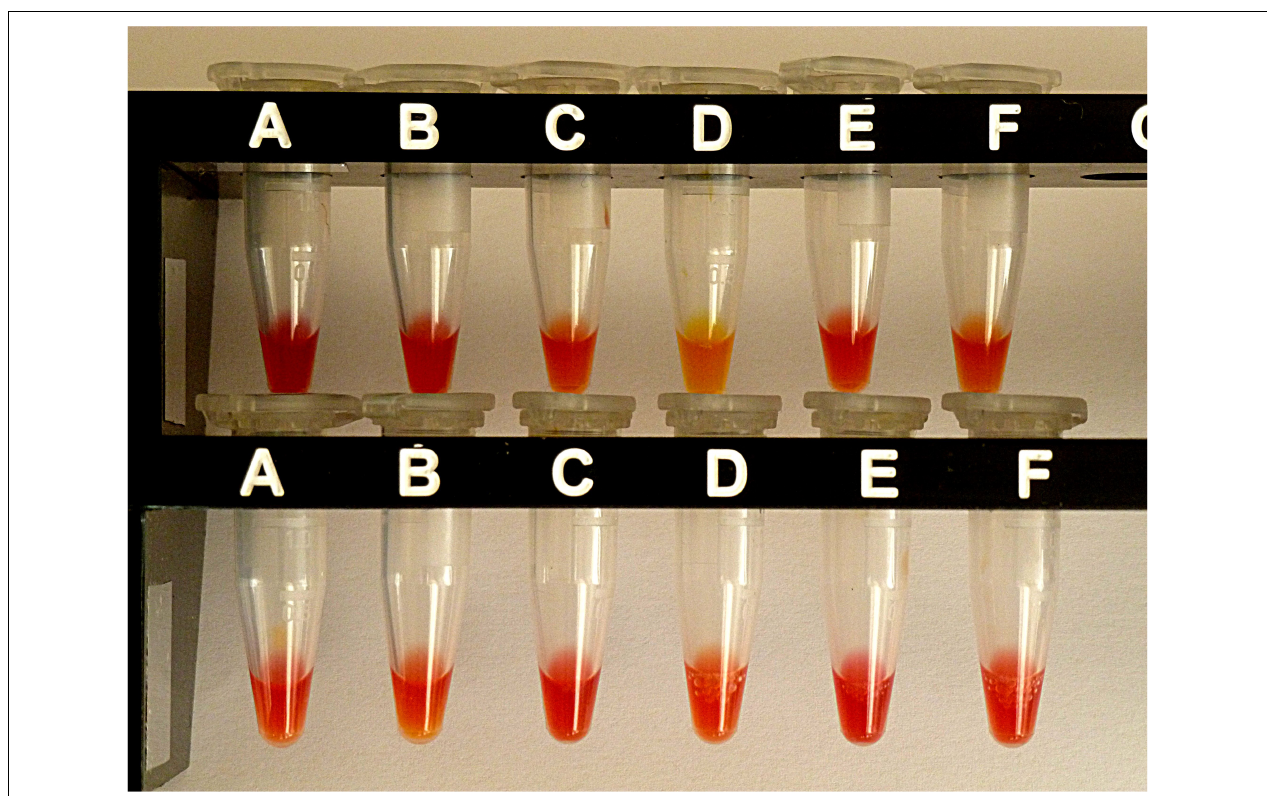
FIGURE 4 | Results from CNPt-direct after exposure for 2 hr at 36 ◦ C. Matched pairs of isolate without and with IPM were in upper row (A,B) E. coli ATCC 25922, (C,D) E. coli OXA-48 (No. 16), (E,F) E. kobeii AmpC (No. 79); in lower row (A,B) K. aerogenes AmpC (No. 60), (C,D) K. aerogenes AmpC (No. 61), (E,F) K. aerogenes AmpC (No. 62). With a positive test the matched pair appears red/light-orange, red/dark-yellow, or